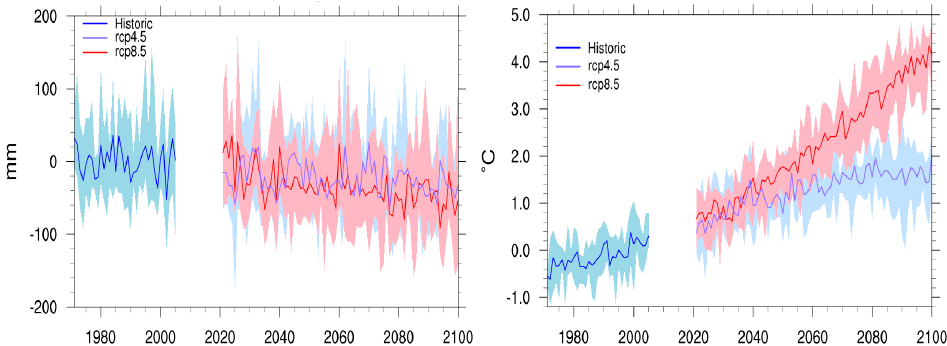
Figure 2. Rainfall and temperature trend of average Coordinated Regional Climate Downscaling Experiment (CORDEX) models outputs under representative concentration pathways (RCP) 4.5 and RCP 8.5 emission scenarios.